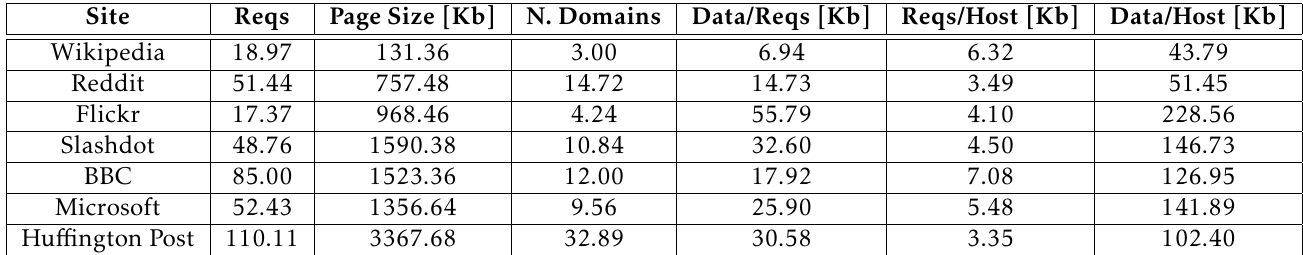
Table 2. Basic Statistics of Websites used as benchmark (average